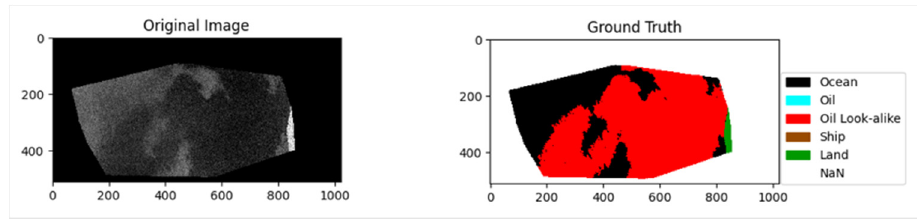
Figure 3. Correct labeling around edges. Nearest neighbor interpolation—label interpolation after augmentation is applied correctly.